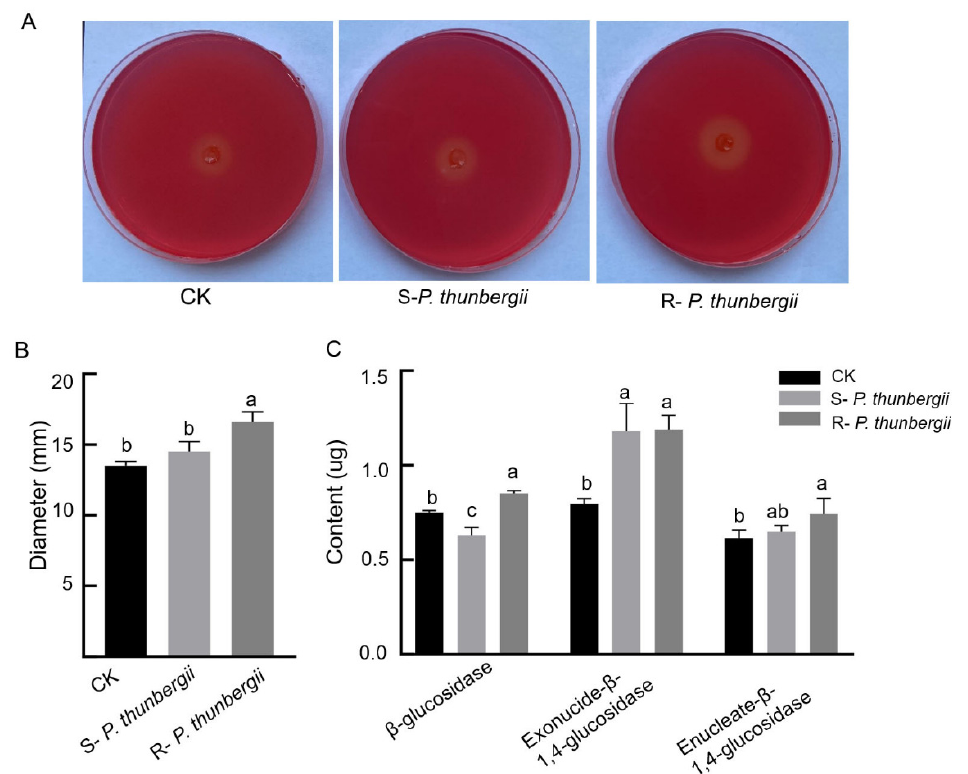
Figure 3. Contents of cellulase secretions by PWNs within P. thunbergii with different levels of resistance. ( A ) Cellulose plate assay (measured by a ruler). ( B ) Cellulase plate assay clear circle diameter (different letters above the error bars indicate statistically significant differences using Duncan’s multiple range test ( p < 0.05)). ( C ) Differences in cellulase content (different letters above the error bars indicate statistically significant differences according to Duncan’s multiple range test ( p < 0.05)). Mock-inoculated P. thunbergii was used as a CK.